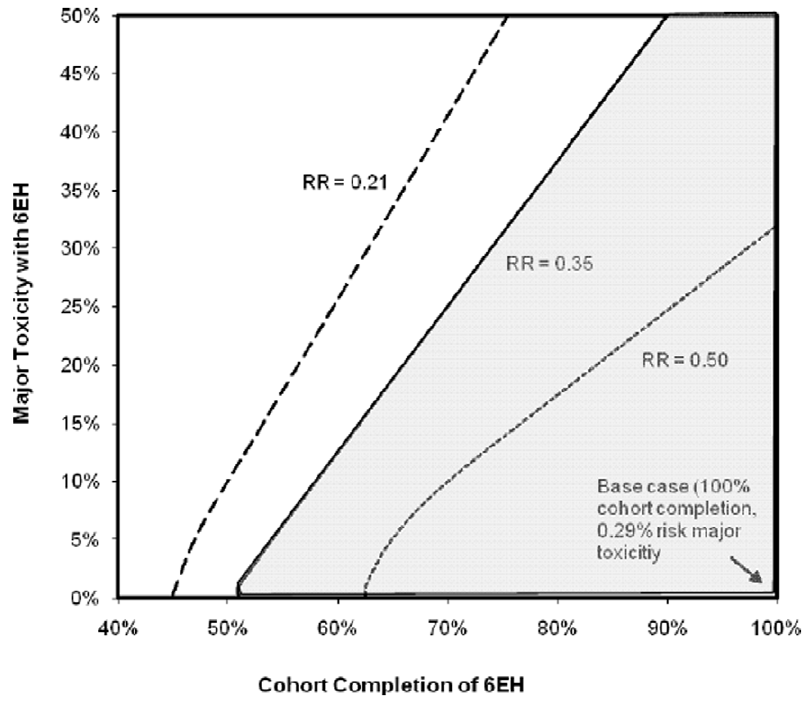
Figure 2. Multi-way sensitivity analysis of 6EH major toxicity, regimen completion, and efficacy . Major toxicity associated with 6EH, percent cohort completion of the regimen, and efficacy of the regimen are varied simultaneously. The solid line represents the point estimate of efficacy for the 6EH regimen as observed in the trial, i.e. a rate ratio of tuberculosis incidence of 0.35 compared to no IPT, varied over a range of percent cohort completion of the regimen and probability of major toxicity. The shaded area to the right of the line represents all values at which the 6EH regimen is cost-effective, based on 3x the GDP per capita of India. The hatched line represents the leftwards shift in the boundary of cost- effectiveness when the rate ratio of TB incidence with 6EH is 0.21 compared to no IPT, as calculated from the lower bound of the 95% confidence interval of the trial. The dotted line represents the rightwards shift in the boundary of cost-effectiveness when the relative risk of TB with 6EH is 0.50 compared to no IPT, as calculated from the upper bound of the 95% confidence interval of the trial. The diamond in the lower right corner represents the base case, trial-based scenario, where percent cohort completion is 100% and the probability of major toxicity is 0.0029. 6EH: Six-month regimen of isoniazid plus ethambutol, IPT : Isoniazid-based Preventive Therapy, GDP : Gross Domestic Product.